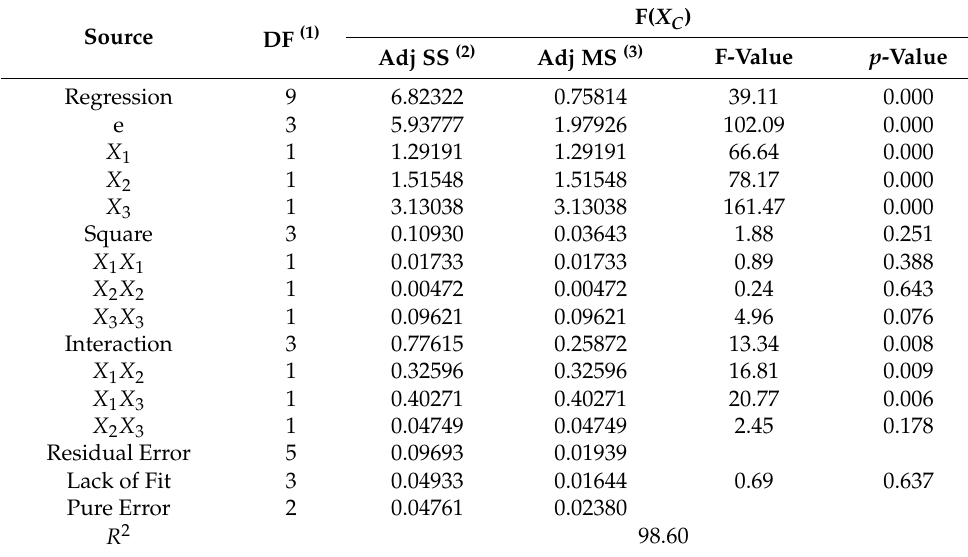
Table 4. Matrix design results for the experiments performed according to the Box–Behnken exper- imental design for the color response values (F( Xc )) of the sprayed SAEW droplet dispersion and contact